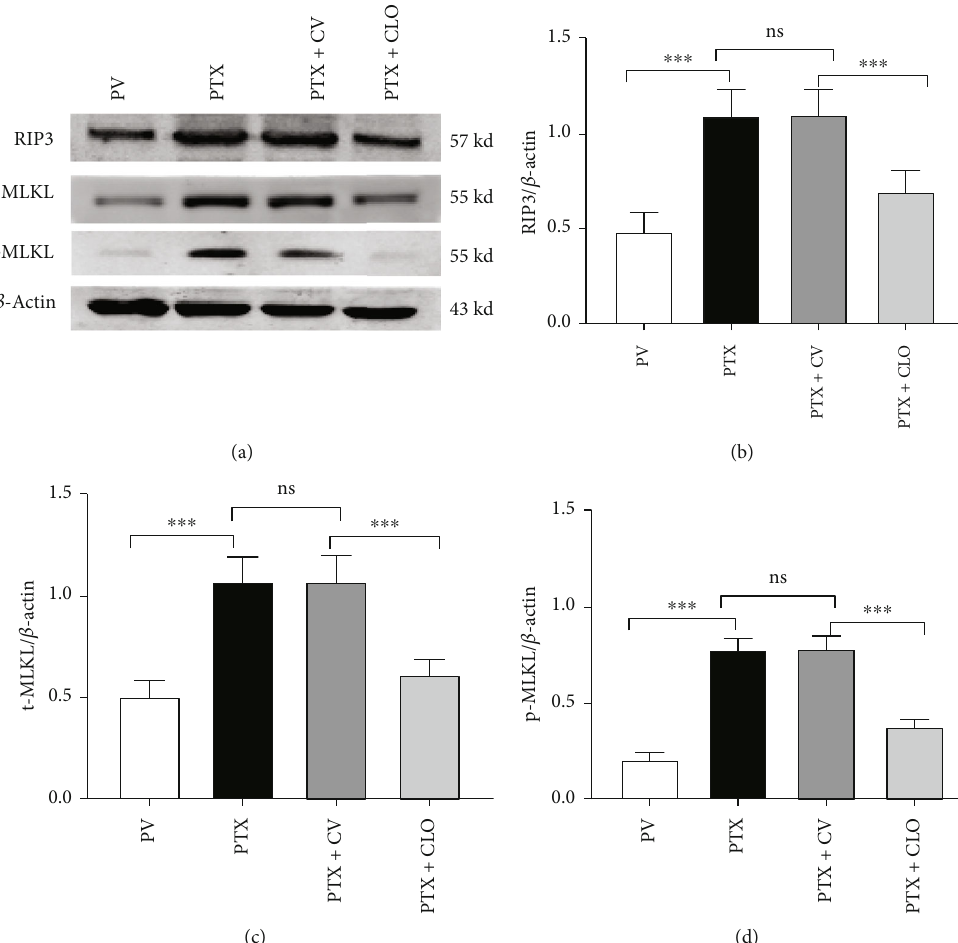
Figure 4: Quantitative analysis of necroptosis-related proteins in the DRG via Western blot on day 14. Imaging and quantitative analyses indicate the levels of RIP3, MLKL, and pMLKL in the DRG of rats on day 14. Data are expressed as the mean ± SD ( n = 6 in each group). The results were analyzed using one-way ANOVA followed by the LSD post hoc test. Asterisks indicate signi fi cant di ff erence between two groups at ∗∗∗ P < 0 : 001 ; ns: no signi fi cant di ff erence. Abbreviations: RIP3, receptor-interacting protein kinase 3; MLKL, mixed-lineage kinase domain-like protein; pMLKL: phosphorylated MLKL; PTX, paclitaxel; CLO, clodronate disodium